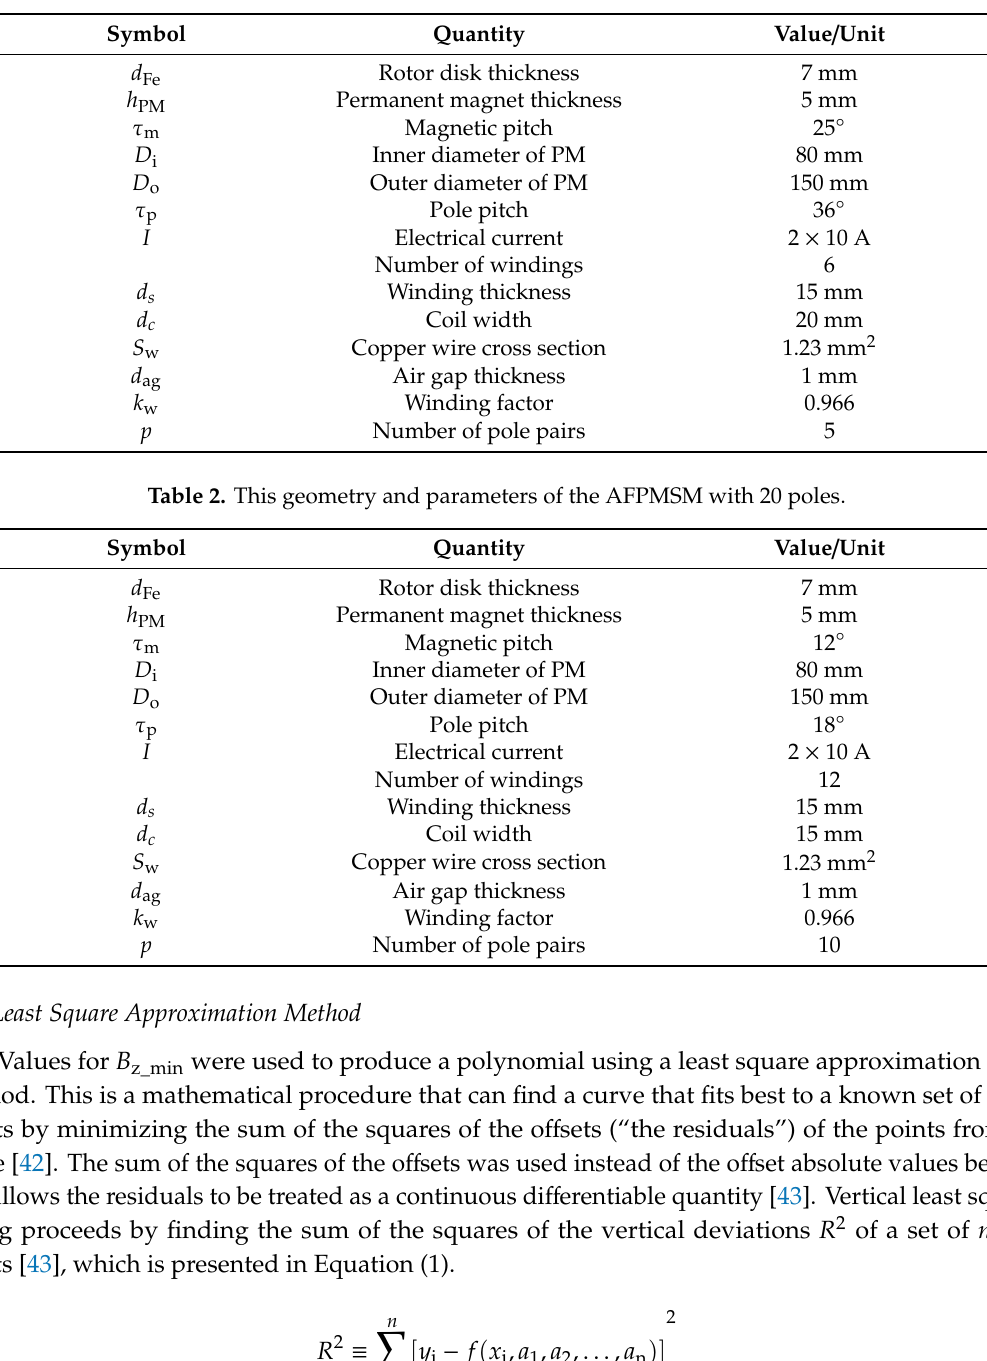
Table 1. This geometry and parameters of the AFPMSM with 10 poles.